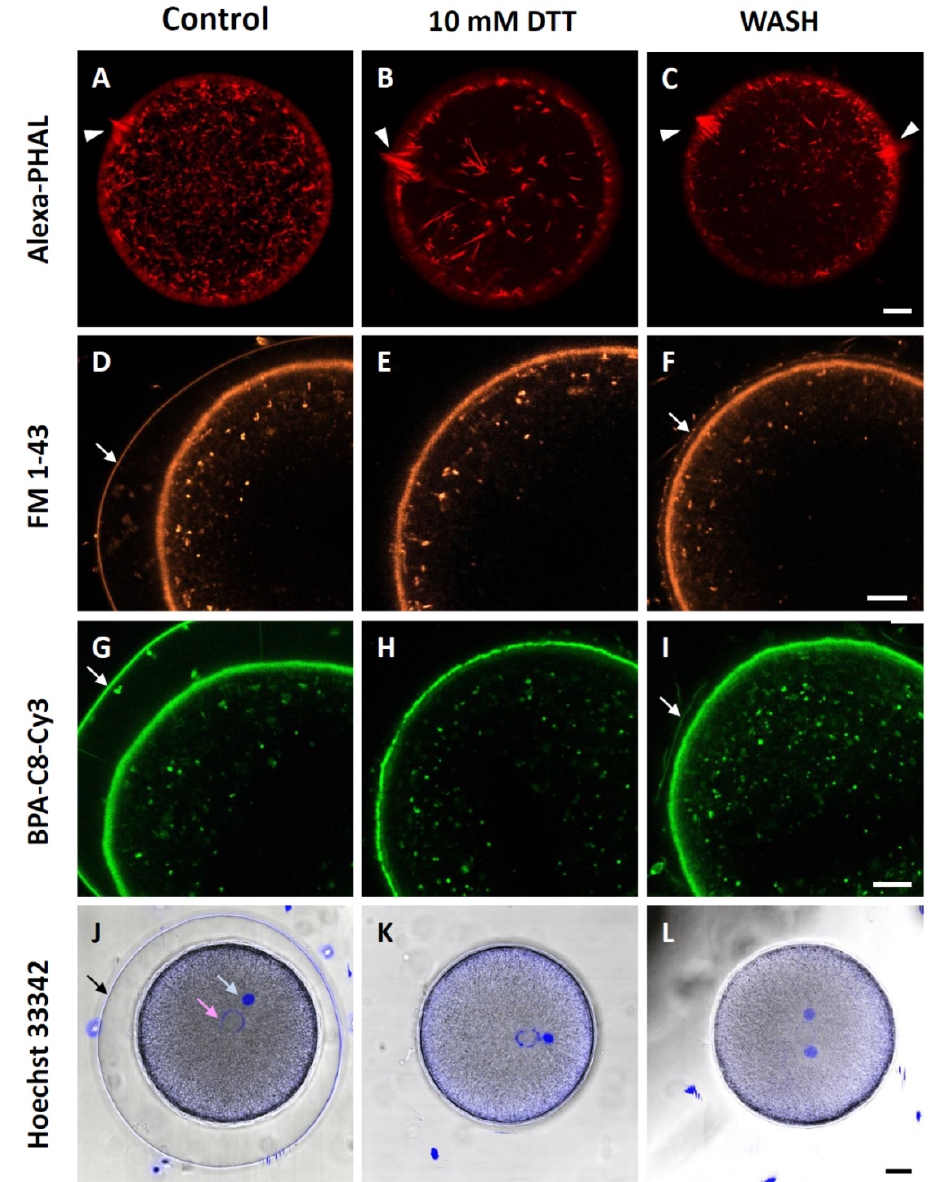
Figure 6. Effect of DTT pretreatment on the late events of fertilization. ( A – C ) P. lividus eggs were microinjected with F-actin dye, AlexaFluor 568-phalloidin, and preincubated in seawater in the presence or absence (control) of 10 mM DTT for 10 min prior to fertilization. After 10 min, the actin cytoskeleton of the fertilized eggs was visualized by confocal microscopy. The fertilization cones are marked by arrowheads. ( D – I ) Eggs pretreated in the same conditions as above (but without F-actin dyes) were fertilized and incubated in the presence of FM 1-43 ( D – F ) or BPA-C8-Cy3 ( G – I ). White arrows indicate the fertilization envelope and its remnants. ( J – L ) Hoechst 33,342 introduced with sperm visualized the male and female pronuclei of the zygotes in the given conditions, as indicated by pale blue and pink arrows, respectively. The black arrow indicates the fertilization envelope. These images are representative of at least two independent experiments. Scale bar, 10 µ